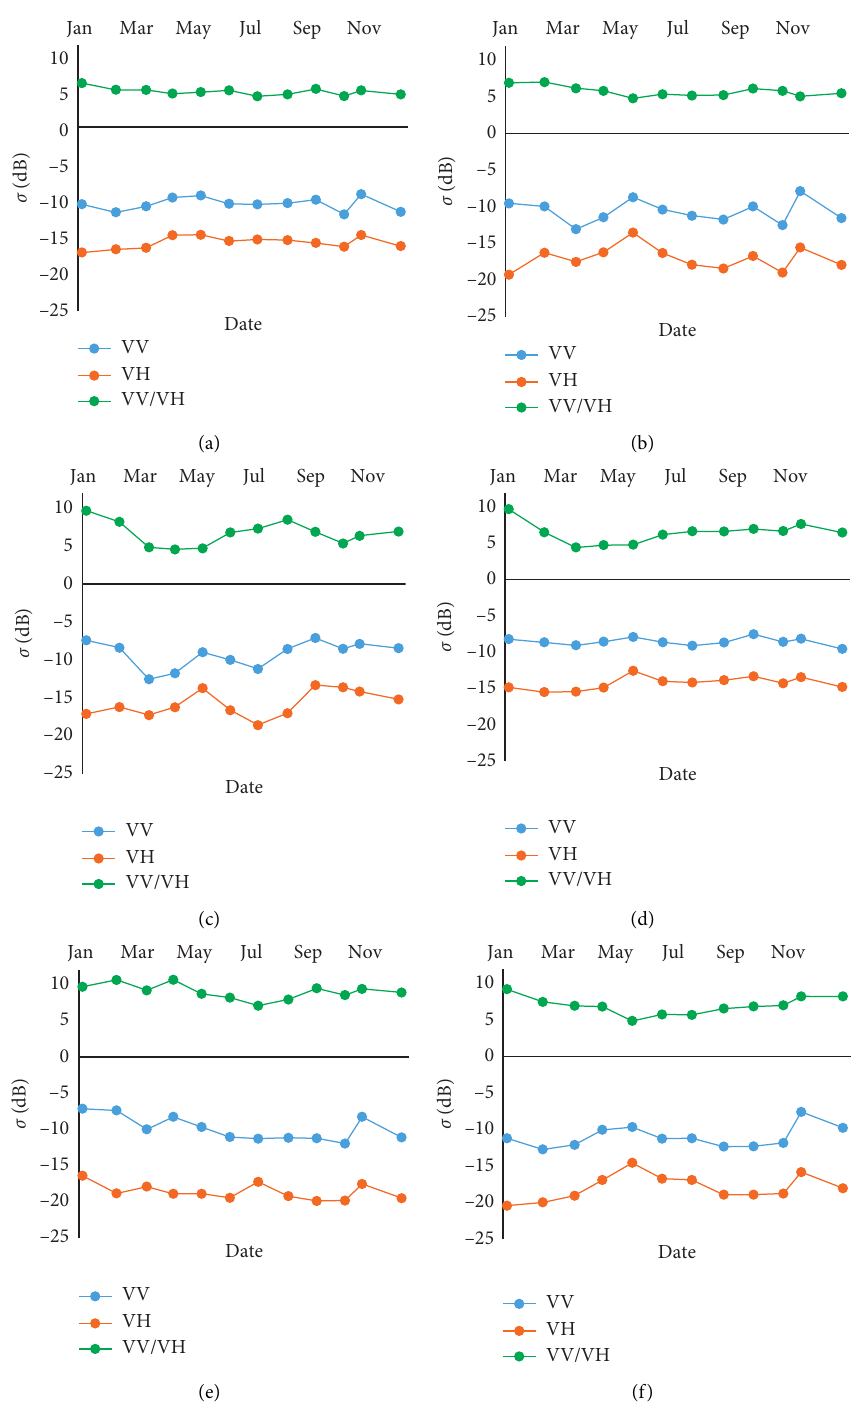
Figure 7: VV, VH, VV/VH, and VV-VH profiles for the different classes chosen in zone R3 for the year 2018. (a) Oranges. (b) Cereal. (c) Double cropping. (d) Olive. (e) Bare soil. (d)